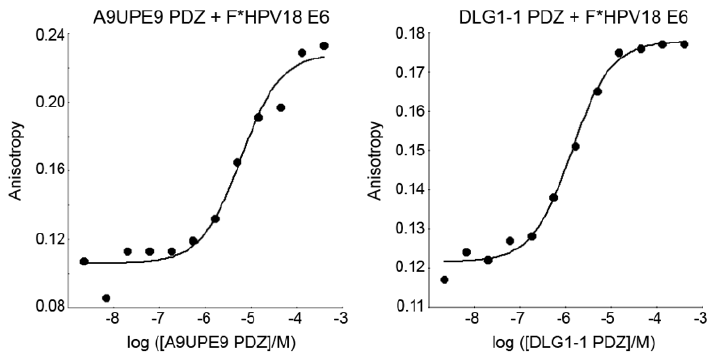
Figure 5. Representative fluorescence polarization experiments to determine K D values of A9UPE9 ( left , as labeled) and DLG1-1 ( right , as labeled) PDZ domains. Overall K D values were calculated from triplicate experiments.